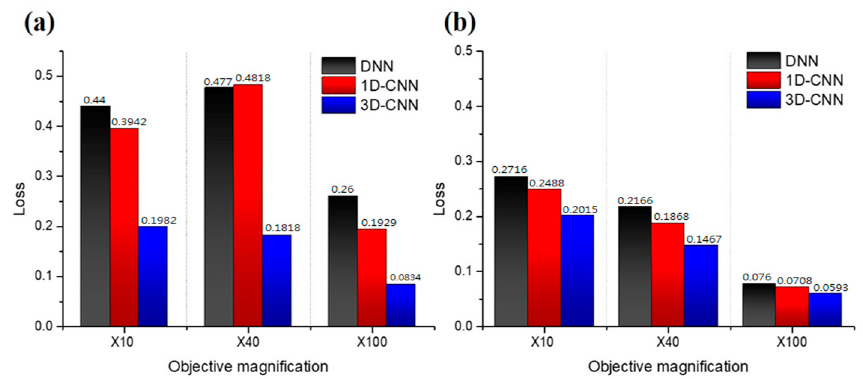
Figure 5. Optimal loss of the three models in the ( a ) training and ( b ) validation sets at 10×, 40×, and 100× magnification rates.